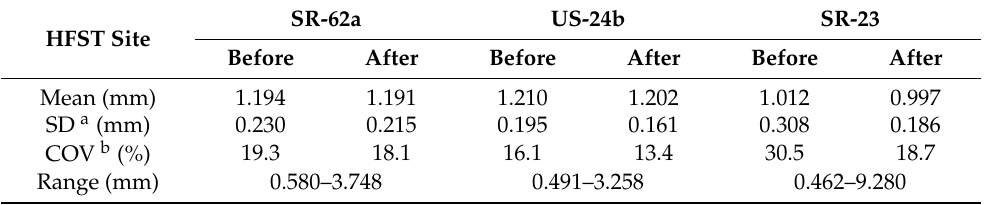
Figure 4. Causes for spikes in mean segment depth (MSD) measurements: ( a ) delamination, US-24b; and ( b ) pop-off and crack spalling, SR-23. and ( b ) pop-off and crack spalling, SR-23. Table 4. Summary statistics of MSD measurements before and after removing spikes. Table 4. Summary statistics of MSD measurements before and after removing